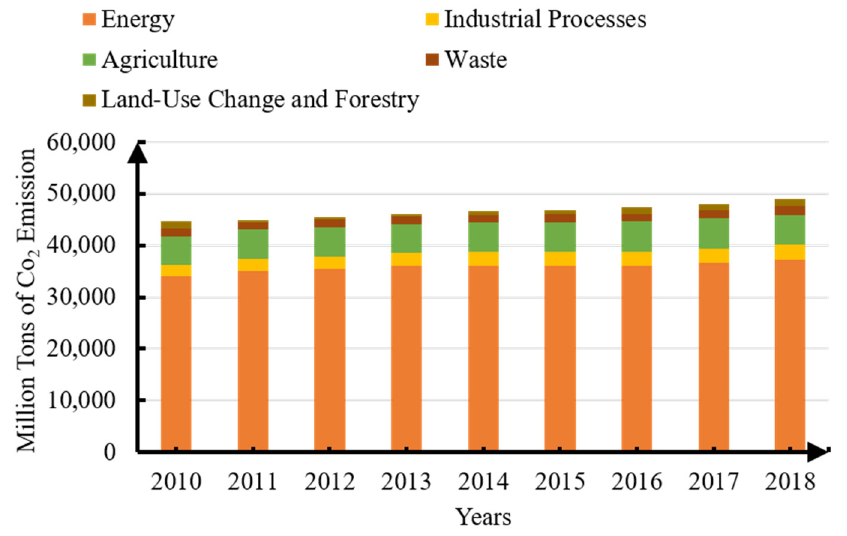
Figure 1. Sector wise contribution to GHG emissions from 2010 to 2018 Data Source: World Resource Institute.